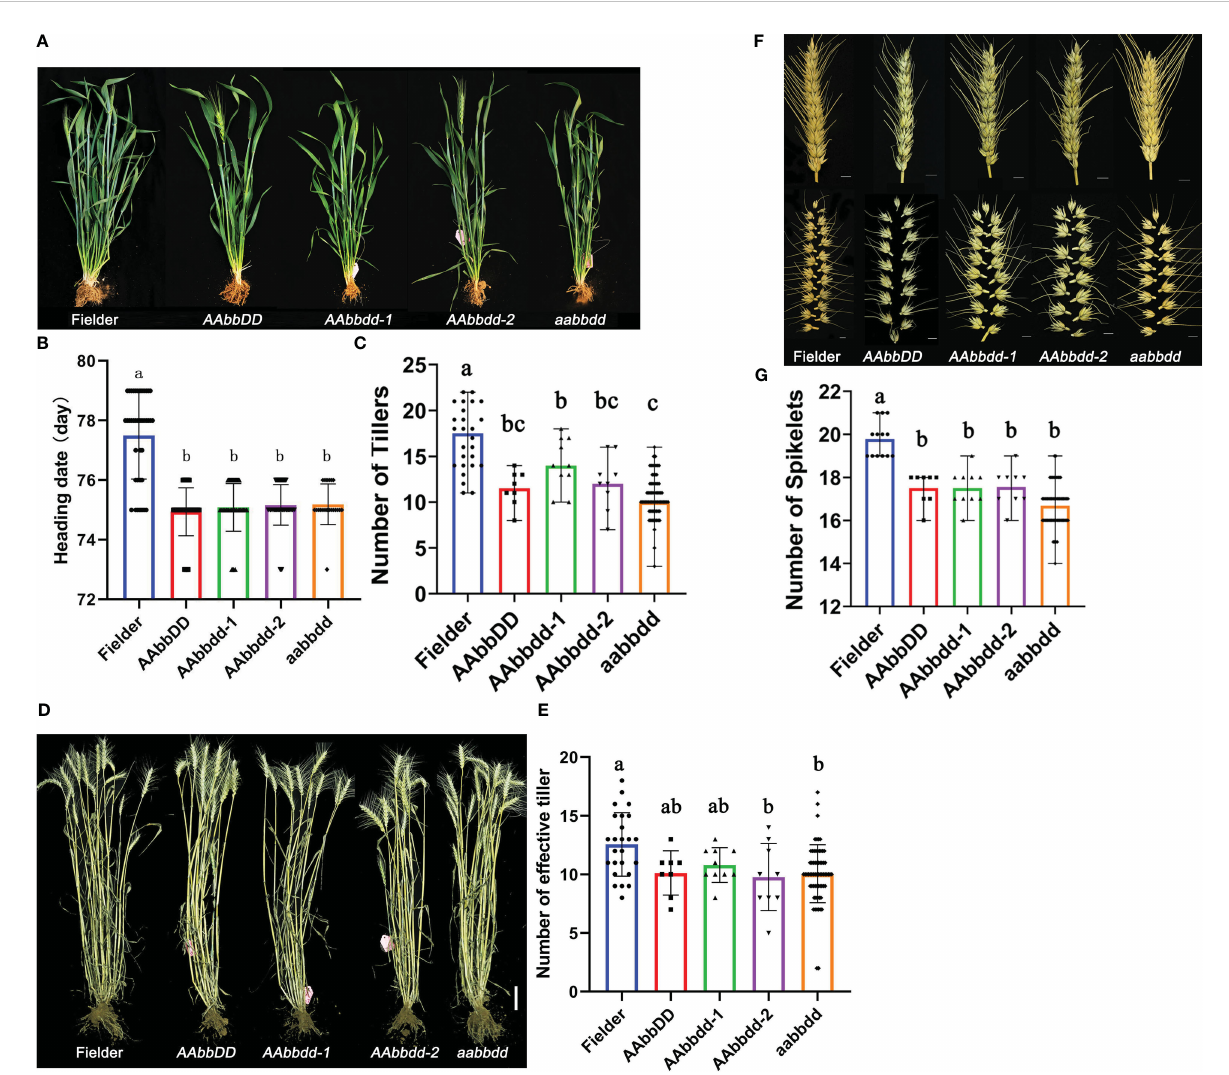
FIGURE 4 Phenotypes of wheat plants with TaTFL1-5s edition. (A) Appearance of plants of Fielder and the mutant lines at heading stage. Bar, 100 mm. (B) Statistics analysis of the heading data of Fielder and the mutant lines. Signi fi cant differences are denoted with distinct letters (Tukey ’ s post hoc test, p < 0.05). The error bars indicate the standard deviation of triplicate values. (C) Statistics analysis of tiller number of Fielder and the mutant lines at heading stage. Signi fi cant differences are denoted with distinct letters (Tukey ’ s post hoc test, p < 0.05). The error bars indicate the standard deviation of triplicate values. (D) Appearance of plants of Fielder and the mutant lines at maturity. Bar, 100 mm. (E) Statistics analysis of effective tiller number of Fielder and the mutant lines at maturity. Signi fi cant differences are denoted with distinct letters (Tukey ’ s post hoc test, p < 0.05). The error bars indicate the standard deviation of triplicate values. (F) Appearance of spike (up panel) and spikelet (down panel) of Fielder and the mutant lines at mature stage. Bars, 10 mm. (G) Statistics analysis of the spikelet number per spike of Fielder and the mutant lines. Signi fi cant differences are denoted with distinct letters (Tukey ’ s post hoc test, p < 0.05). The error bars indicate the standard deviation of triplicate